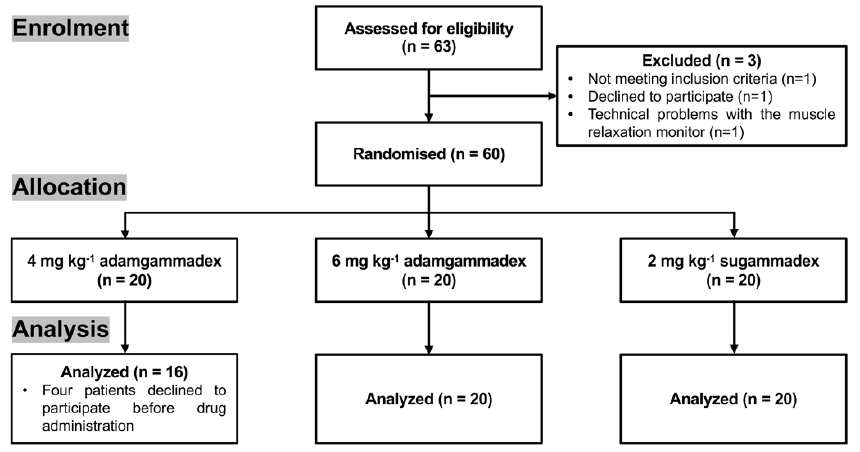
Figure 2. Study flow diagram. Table 1. Subject demographics and baseline